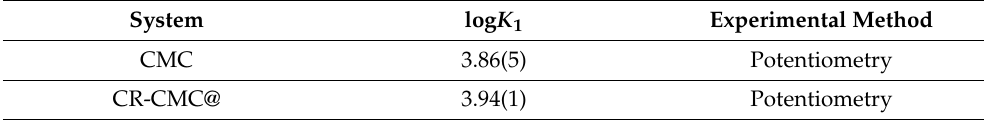
Table 5. Average apparent protonation constant referring to the carboxymethyl groups present in CMC at T = 298 K and I = 0.1 M (KCl). Values in parentheses are standard deviations on the last significant figure. System log K 1 Experimental Method